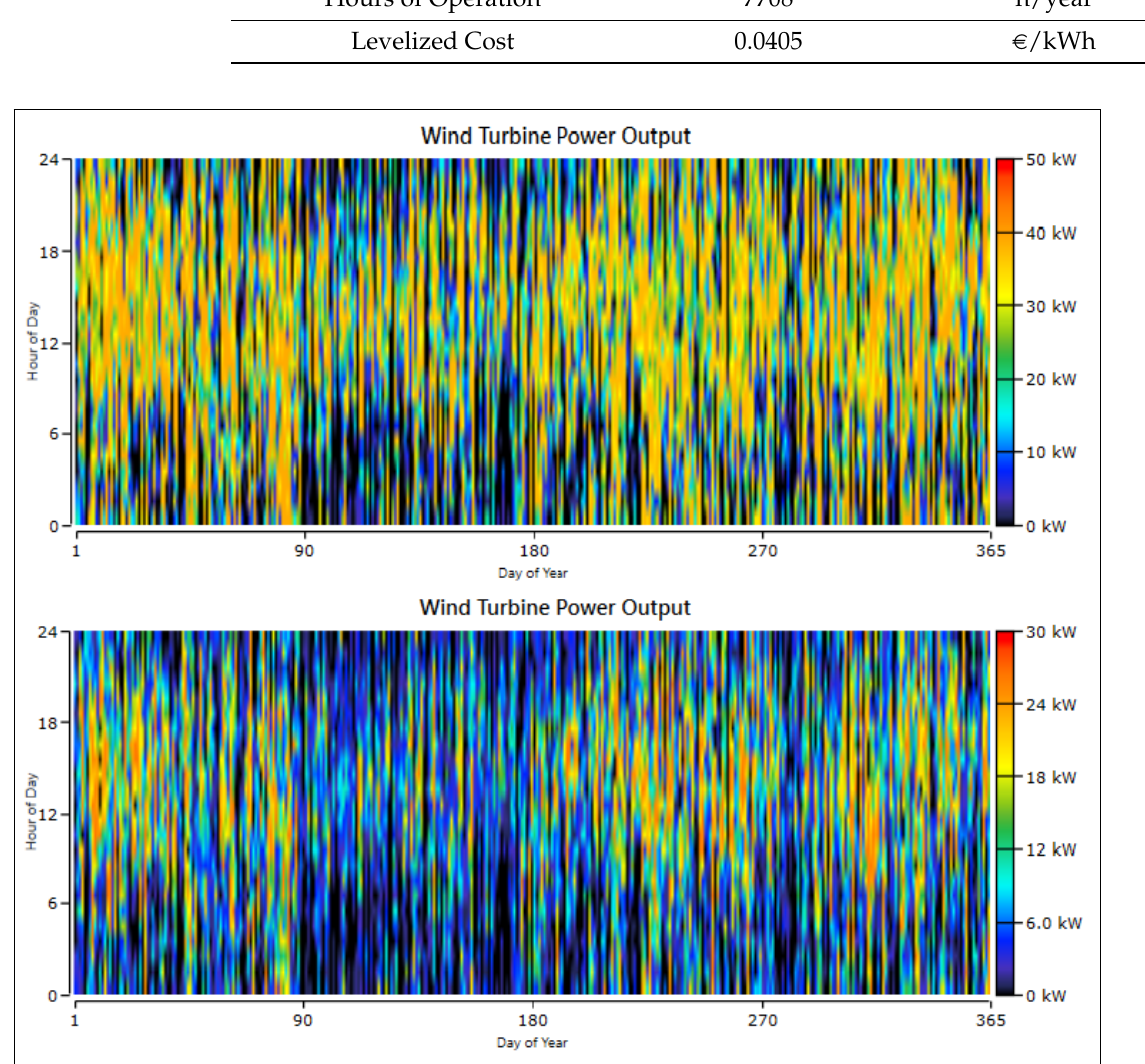
Figure 14. Eocycle EO20 (20 kW) ( upper figure) and Aeolos-H (10 kW) ( down figure) power output Scenario